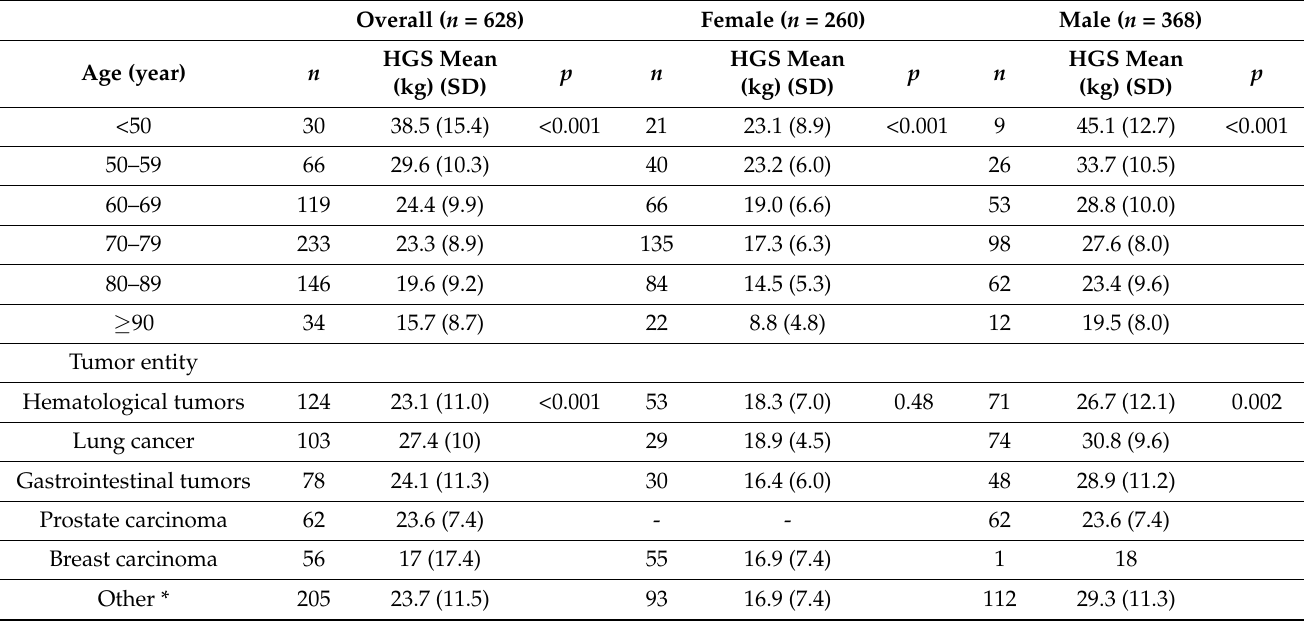
Table 2. Handgrip strength according to tumor entity and